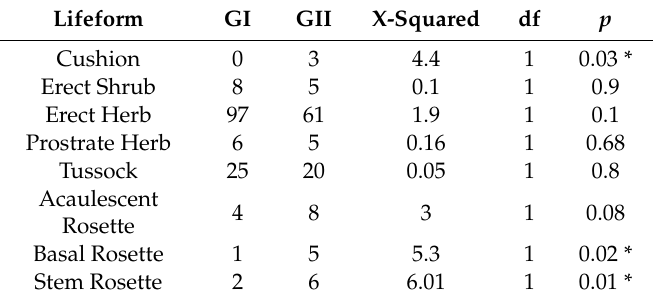
Table 2. p -Values of Kruskall–Wallis test, comparing the frequency of lifeforms. * p < 0.05.